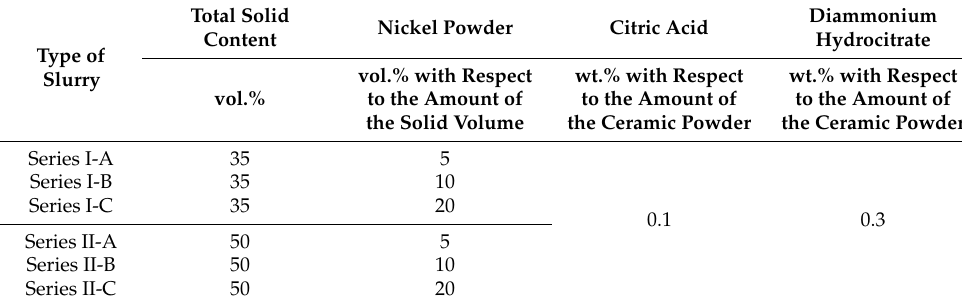
Table 2. Composition of the slurries used in the investigations.